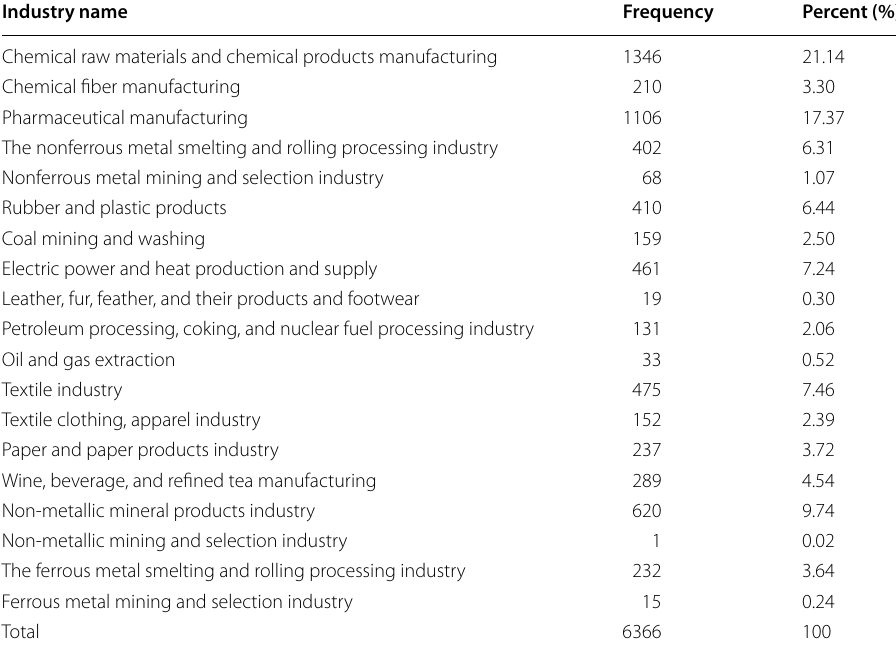
Table 4 The sample industry distribution